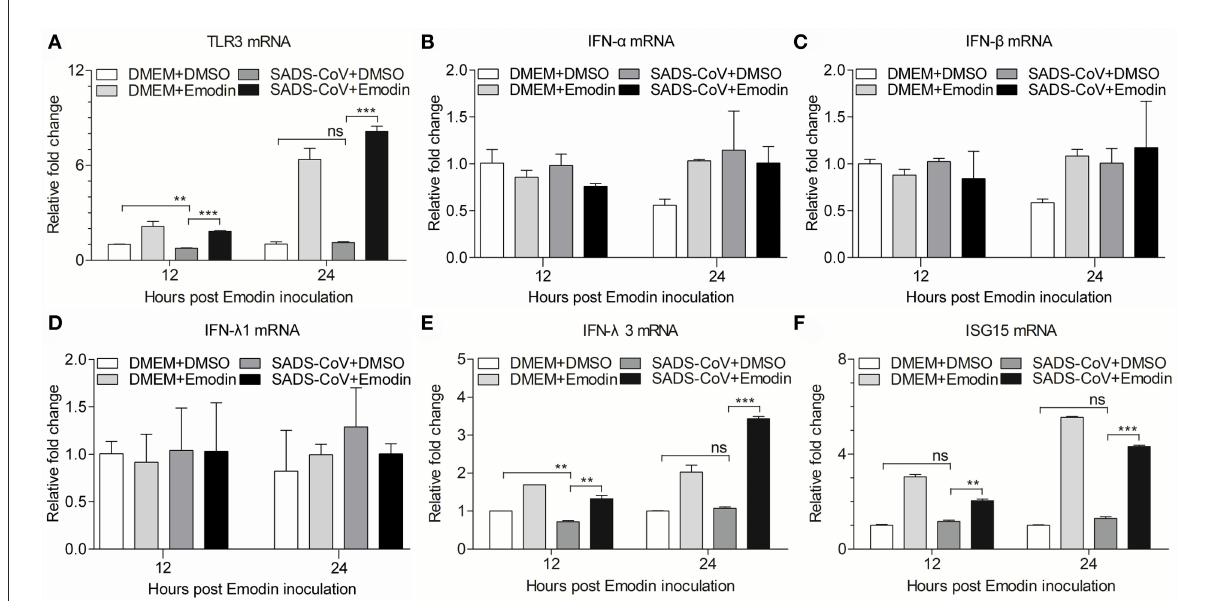
FIGURE6 Emodin induces activation of TLR3-IFN- λ 3-ISG15 pathway in SADS-CoV-infected cells. IPI-FX cells were incubated with Emodin (12.5 µ g/ml) or 0.1% DMSO for 1h, followed by infection with SADS-CoV at an MOI of 0.1. After 1.5h, the cells were re-treated with Emodin (12.5 µ g/ml)